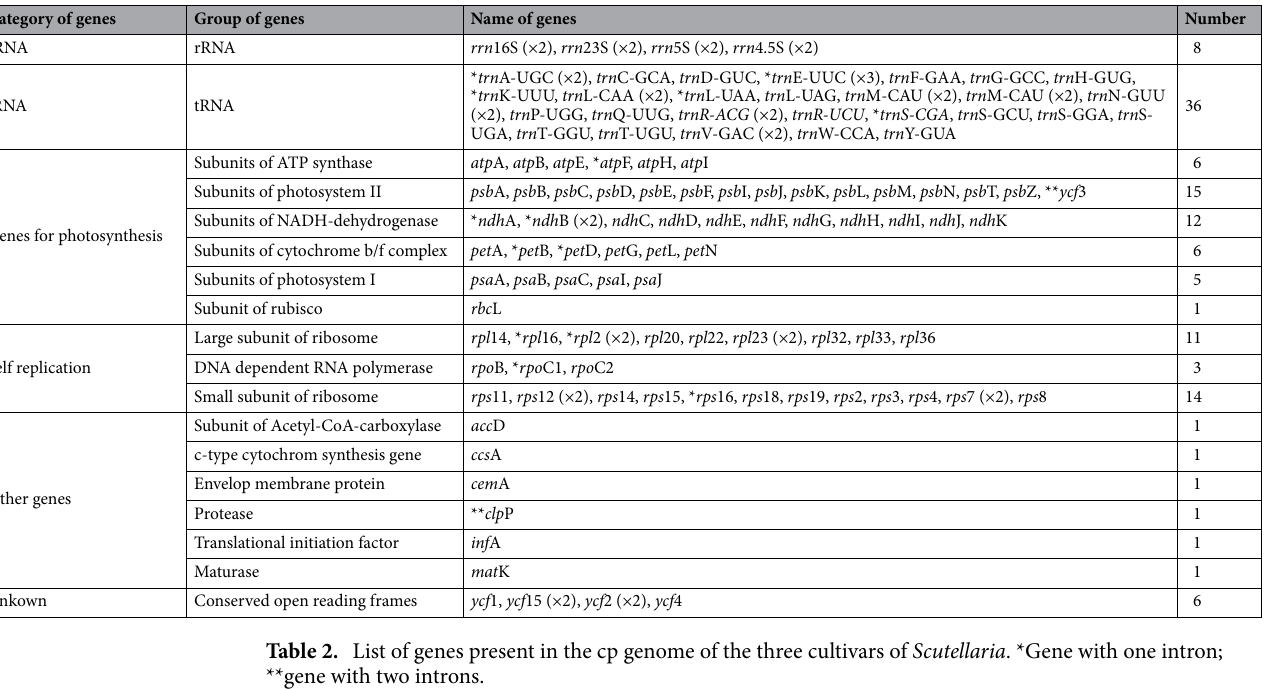
(Table 2). A total of 129 genes in these species, including 85 protein-coding genes, 36 tRNA genes, and 8 rRNA genes. The results were identical to the other members of the genus Scutellaria . Compared with most angio-